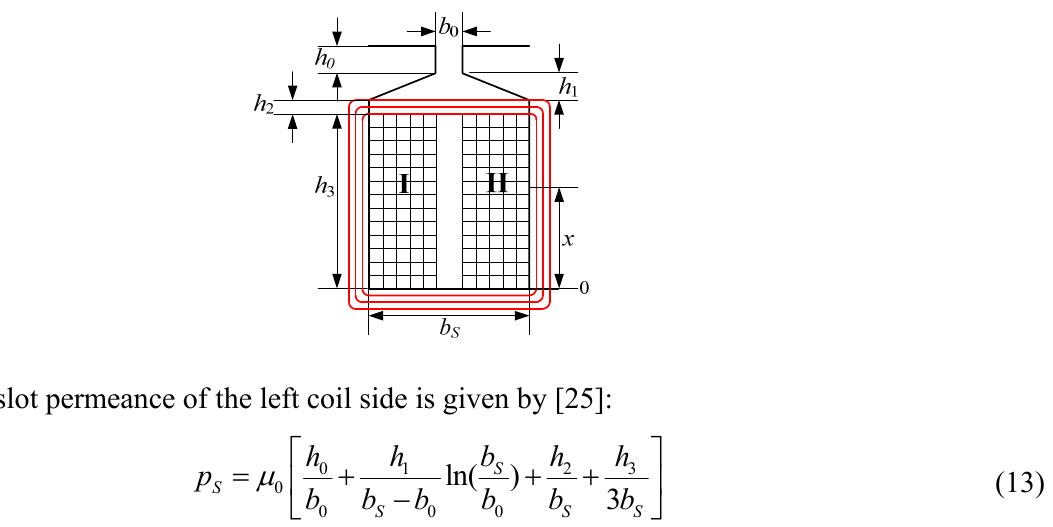
Figure 8. Simplified stator slot with all-teeth-wound